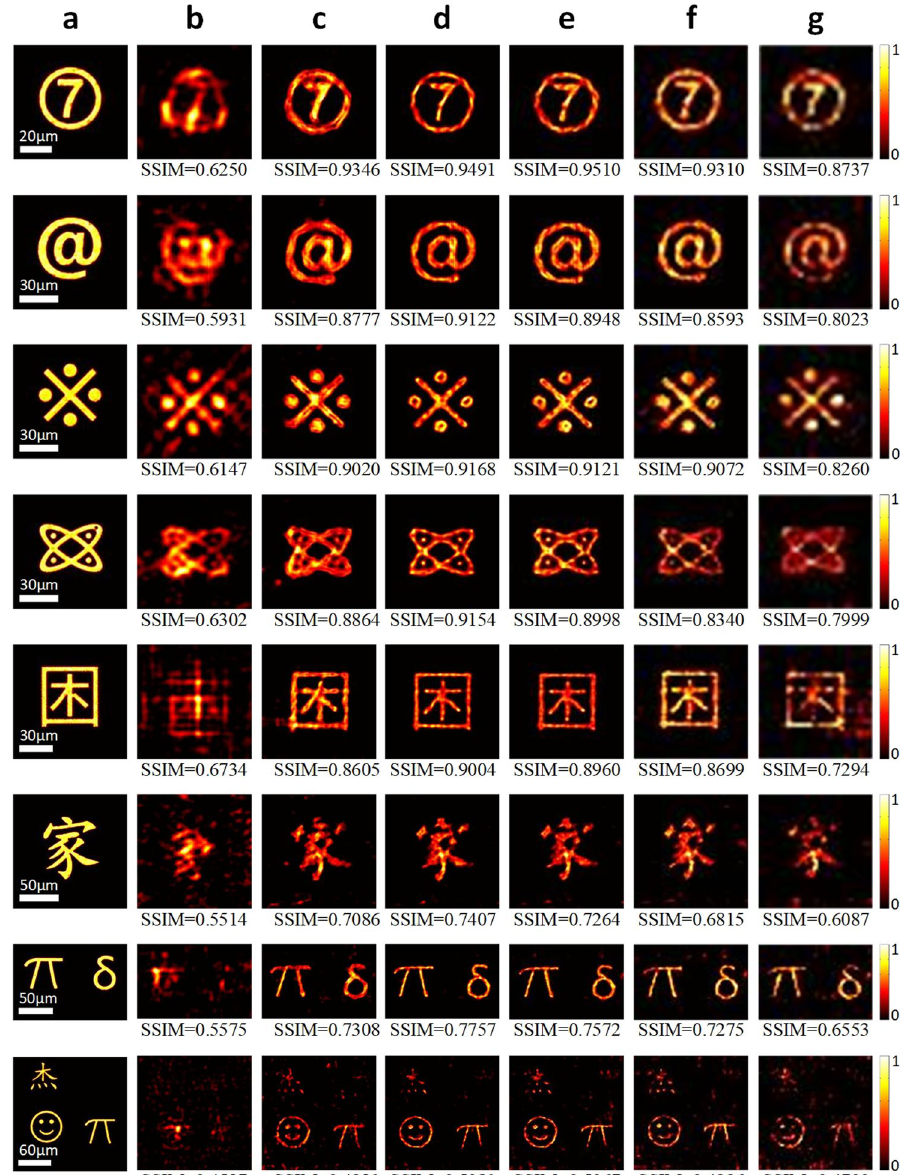
Figure 4. ( a ) To-be-observed targets. ( b ) Reconstructed results using phase retrieval. ( c ) Reconstructed results by deconvoluting IIMs with ̈ S in Fig. 3(f). ( d ) Reconstructed results by deconvoluting IIMs with ̈ S in Fig. 3(g). ( e – g ) Reconstructed results by deconvoluting IIMs in lower sampling rates, 1/2 × 1/2, 1/4 × 1/4 and 1/6 × 1/6, respectively, using down-sampled speckle pattern ̈ S in Fig. 3(g). The SSIMs are calculated using images in ( a ) as ground